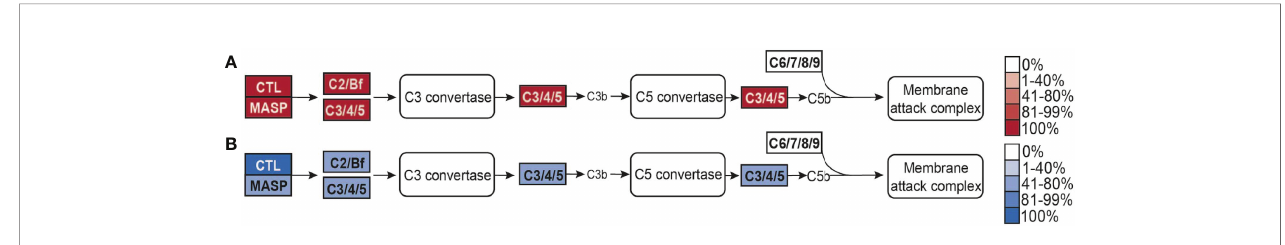
FIGURE 6 | (A, B) Lectin-complement pathway modi fi ed from Kegg pathway. Opacity of the boxes represents the percentage of (A) Anthozoans or (B) Medusozoans with that pathway